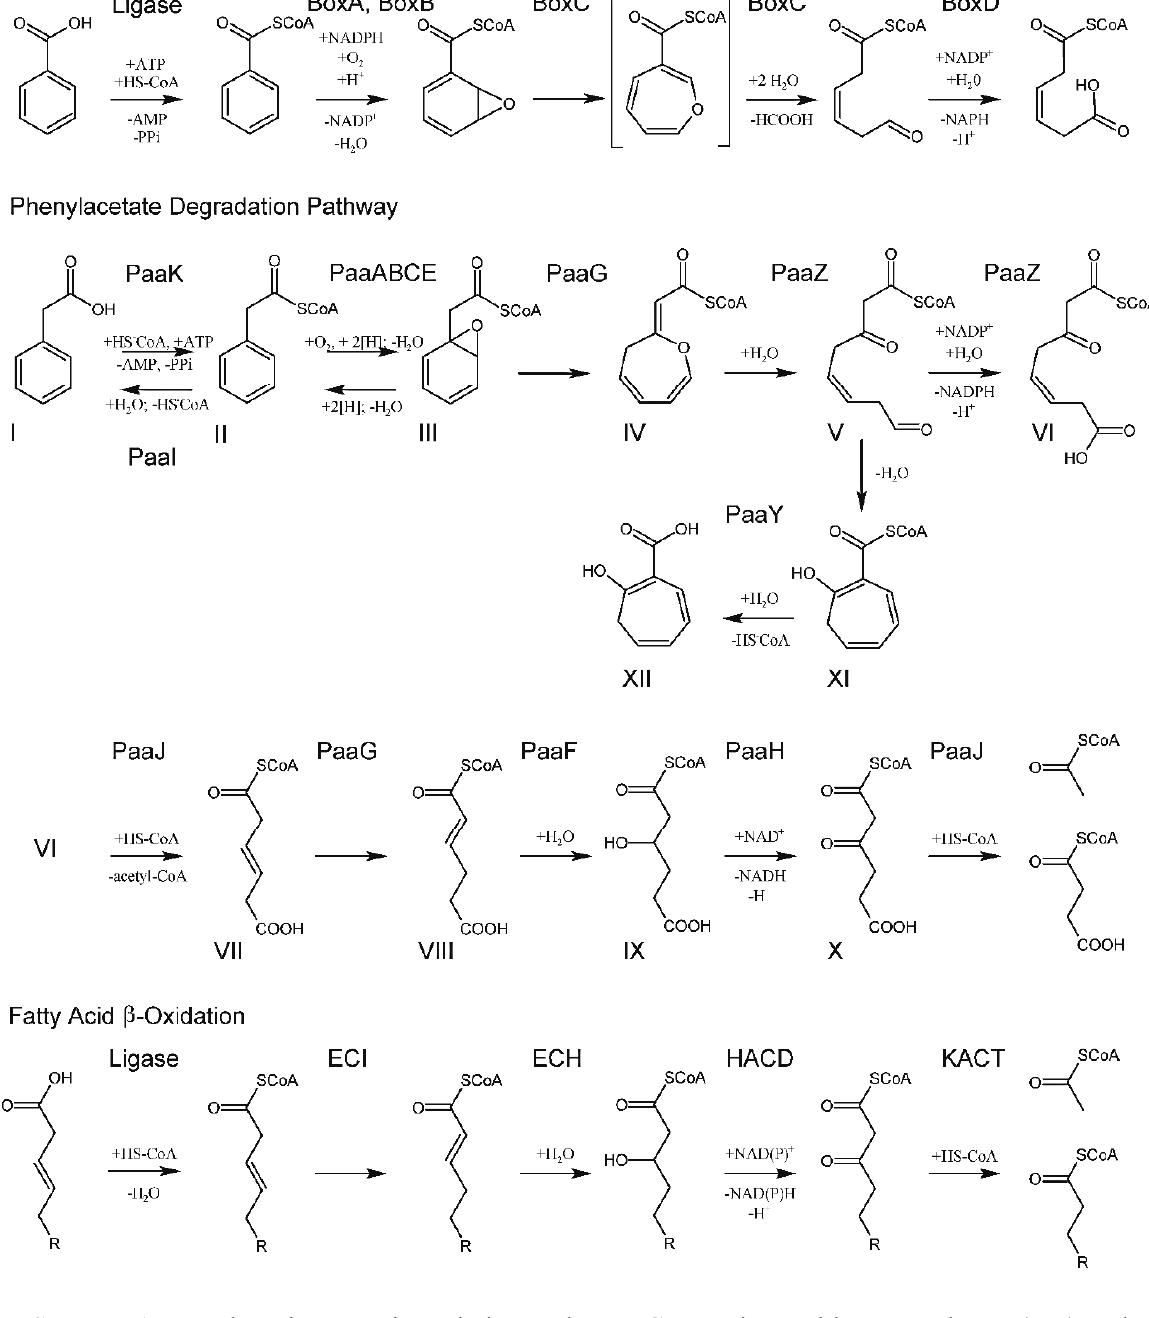
Schema 1. Paa phenylacetate degradation pathway. Comparison with Box pathway ( top )